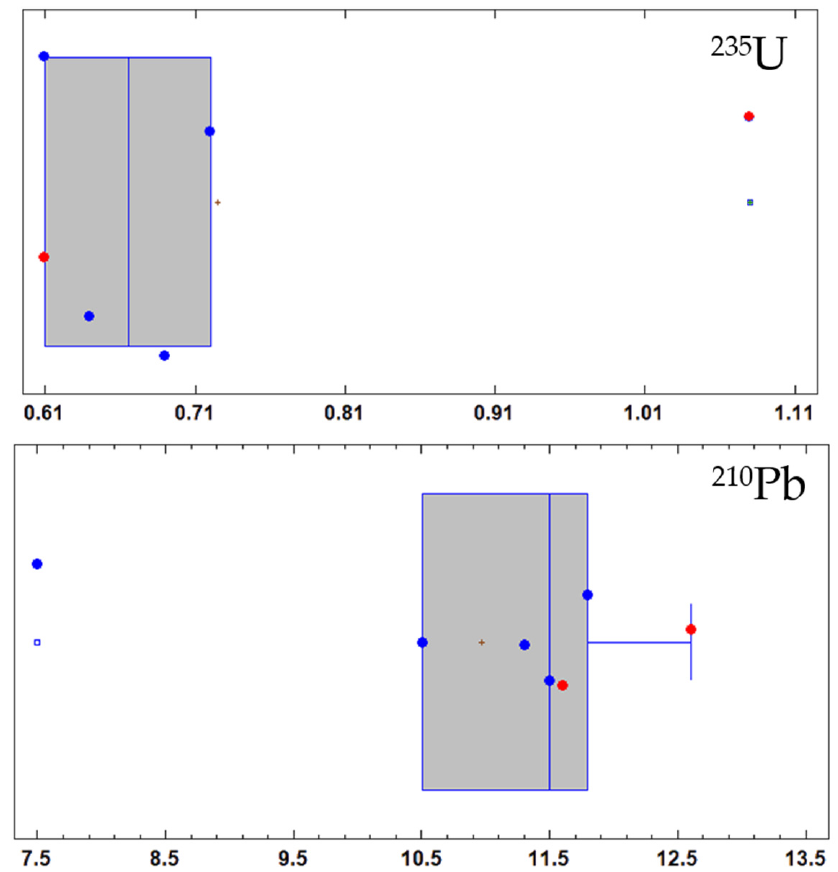
Figure 3. Box-and-whisker plots for 235 U and 210 Pb activity concentrations data recorded in ground mortar made with CEM III/A 42.5 N cement. The red dot shows the value of the non-carbonated mortar, whereas the blue dot presents the activity concentrations measured after the mortar carbonation process at different curing ages.